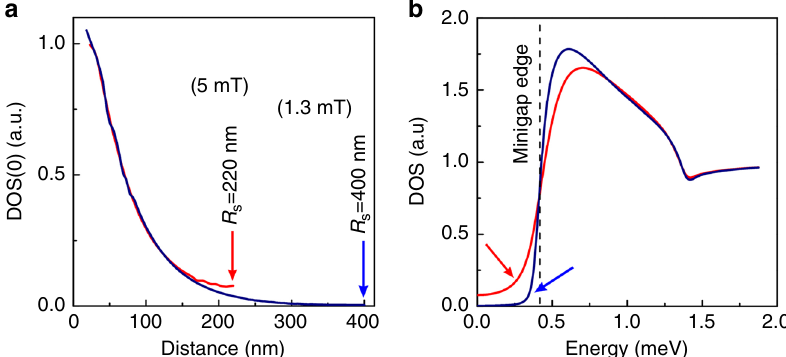
(nm)00.0 Distance Fig. 5 Quasiparticle excitations inside the minigap. a Radial ZB-DOS vortex pro fi le for the 50 nm Cu-thick sample in the fi eld 1.3 mT (blue line) and 5 mT (red line). The pro fi les differ signi fi cantly at the vortex periphery. b Calculated LDOS at the vortex lattice unit cell boundary for the fi elds 1.3 mT (blue curve) and 5 mT (red curve). The minigap fi lling with quasiparticle states is evidenced by